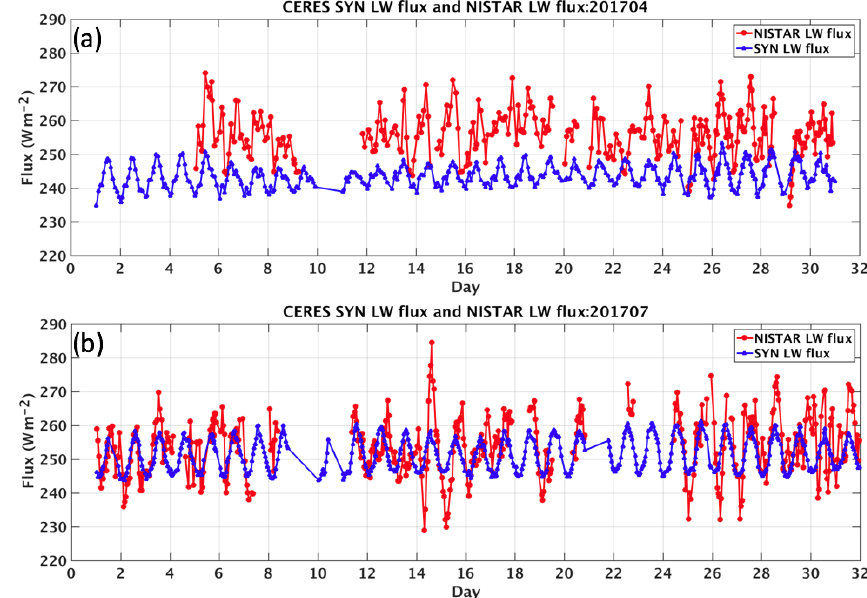
Figure 8. LW flux (Wm − 2 ) comparisons between NISTAR and CERES SYN for April (a) and July (b) 2017.